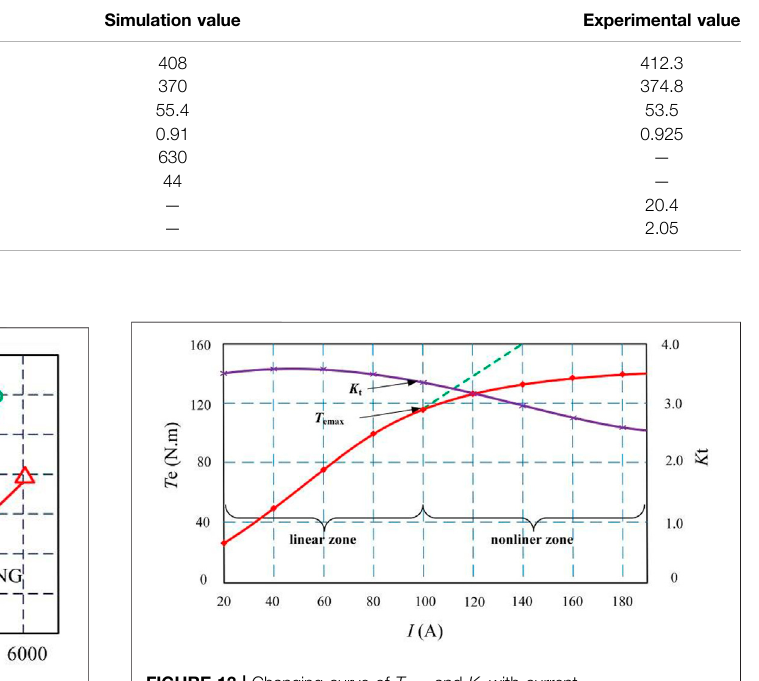
FIGURE 13 | Changing curve of T max and K t with